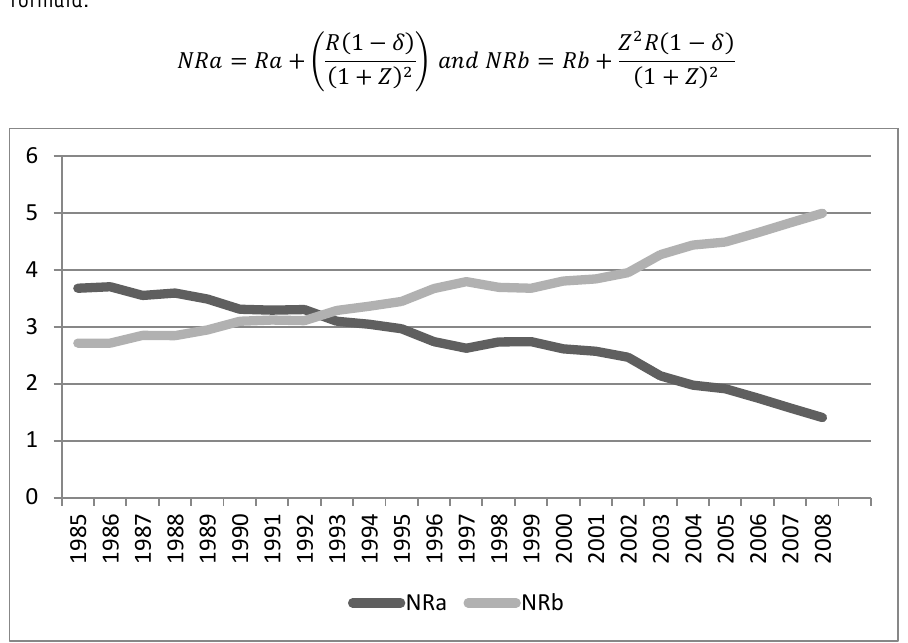
FIGURE 5: Plotting the resource holdings from 1985 to 2008, using 1985 as a base year